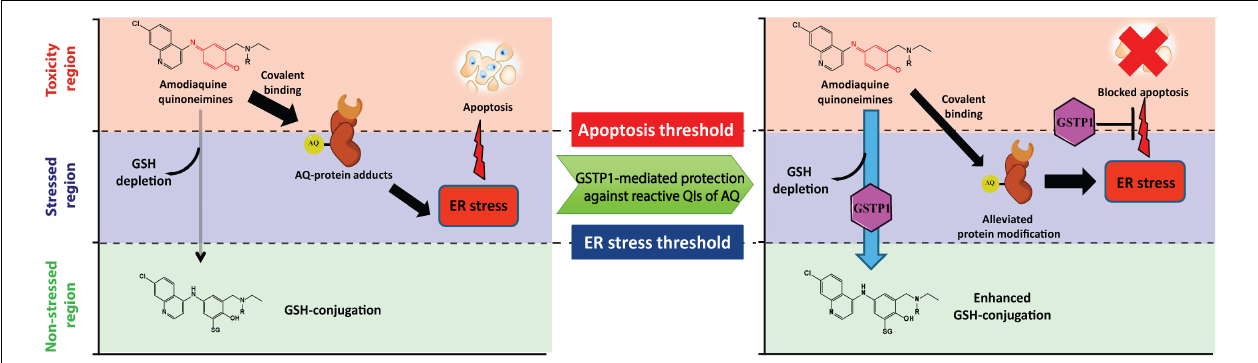
FIGURE 8 | Proposed model for the toxicity of AQ-QI and DEAQ-QI and GSTP1-mediated protection in HepG2 cells. Reactive moieties in the QIs are indicated in red. For AQ-QI, R = -CH 2 CH 3 ; for DEAQ-QI, R = -H. AQ-QI and DEAQ-QI deplete cellular GSH and are conjugated into AQ-SG and DEAQ-SG, respectively. The ER stress response (CHOP) is activated by QI-mediated protein modification and apoptosis is subsequently induced. GSTP1-mediated protection against reactive QIs of AQ is due to enhanced GSH-conjugation and inhibition of